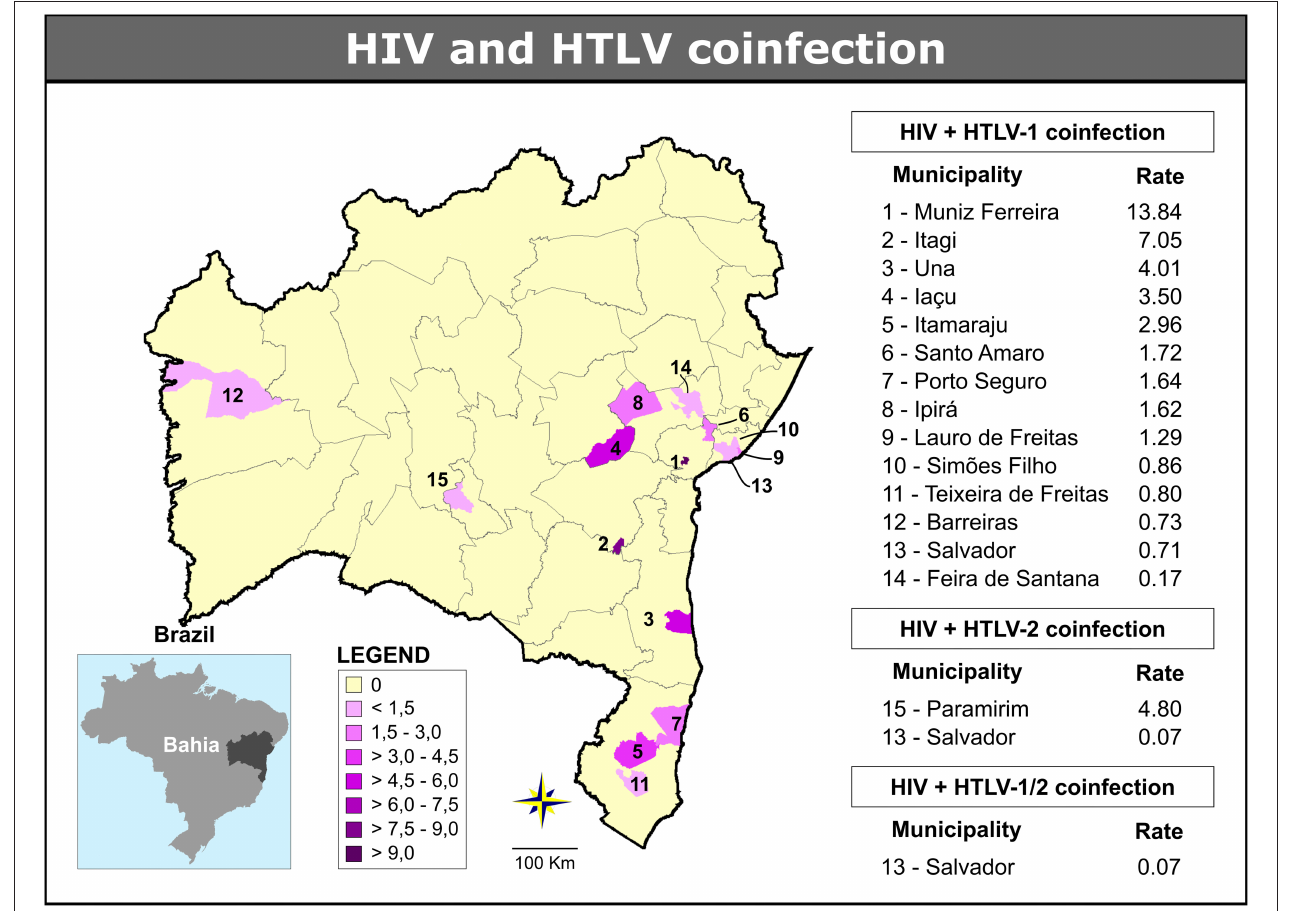
FIGURE 5 | Geographic distribution of cases of HIV/HTLV-1, HIV/HTLV-2, and HIV/HTLV-1/2 coinfection among municipalities in the state of Bahia (2004–2013). Microregions are delimited by gray lines. Public domain digital maps were obtained in shapefile format (.shp), subsequently reformatted and analyzed using QGIS version 3.10 (Geographic Information System, Open-Source Geospatial Foundation Project.